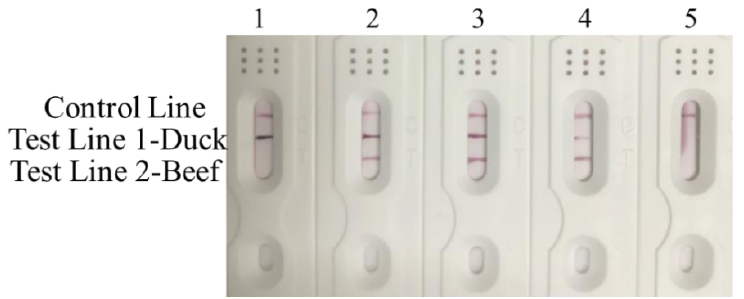
Figure 4. Sensitivity analysis of RPA-MLFD assay for adulterated meat. Lane 1:100% duck; Lane 2: 50% duck + 50% beef; Lane 3: 25% duck + 75% beef; Lane 4: 5% duck + 95% beef; Lane 5: negative control.